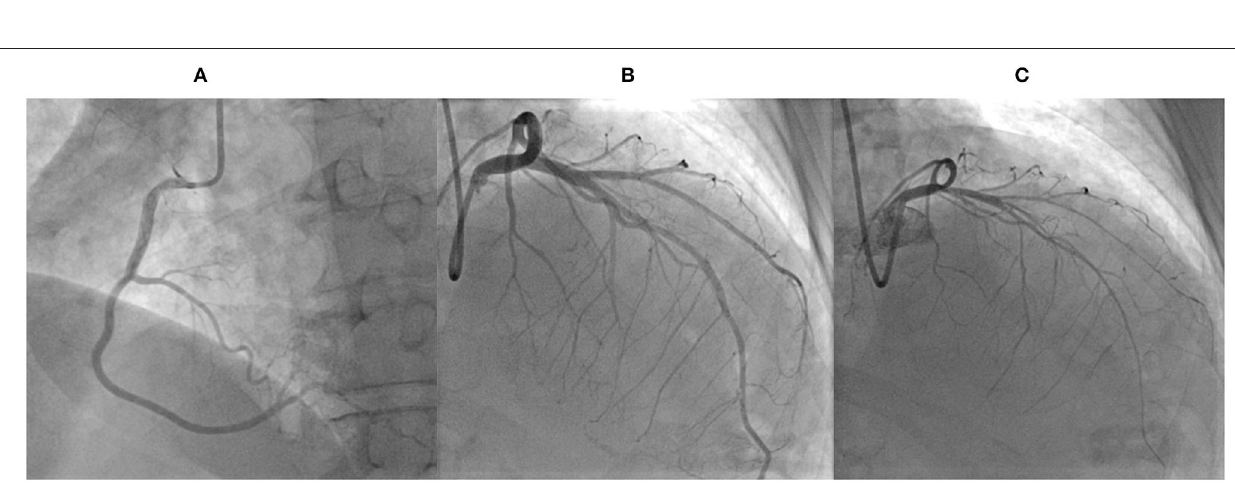
FIGURE 3 | Coronary angiography and acetylcholine test performed during admission. (A) Coronary angiography in the left anterior oblique view showing normal right coronary artery. (B) Cranial right anterior oblique view showing normal left coronary artery. (C) Cranial right anterior oblique view revealing spasm of both the left anterior descending and circumflex arteries, during an acetylcholine provocative